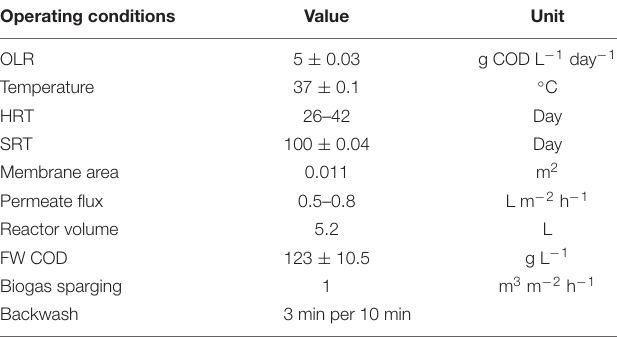
TABLE 1 | Operating conditions of the SP and TP-MP AnMBRs.